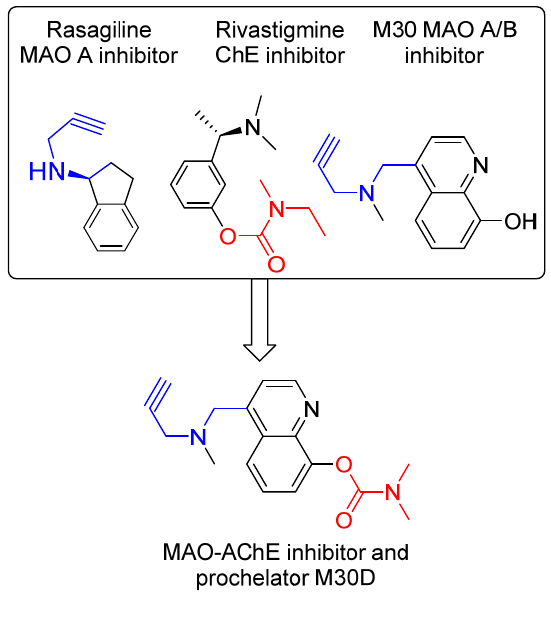
Figure 5. Design strategy resulting in multi-target ligand M30D, which contains propargylamine moiety (blue part) from anti-PD drug rasagiline and (dimethylcarbamoyl)oxy moiety (red part) from anti-AD drug